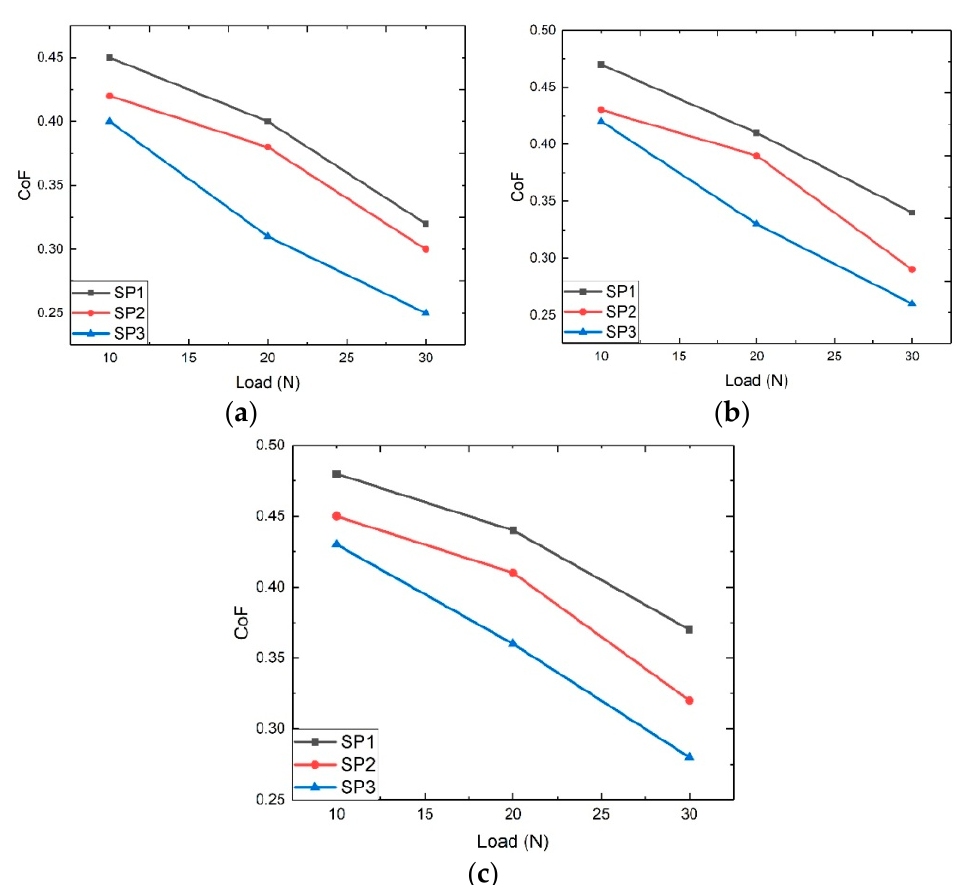
Figure 7. Influence of load on CoF at a speed of ( a ) 500 rpm, ( b ) 600 rpm and ( c ) 700 rpm.